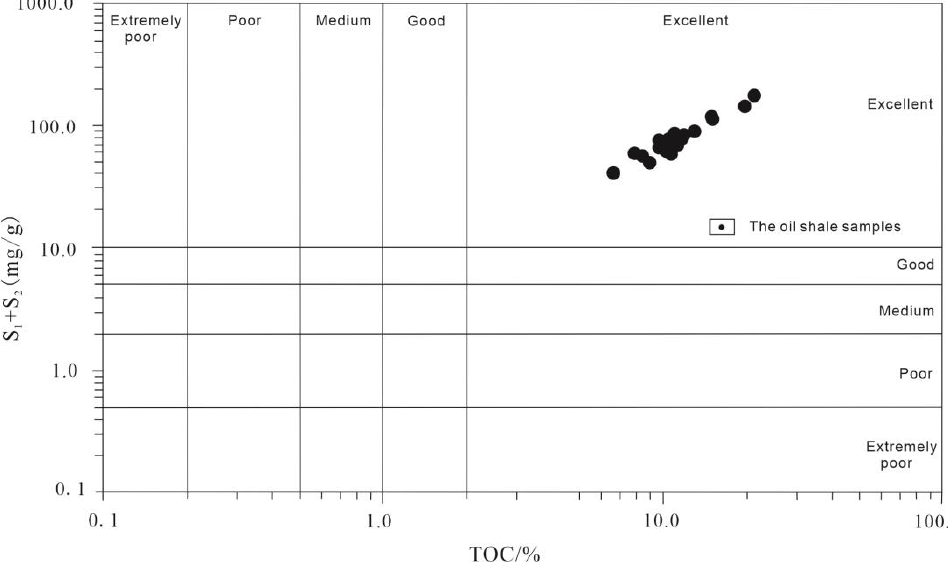
Figure 8. TOC-S 1 + S 2 intersection map of oil shale in Youganwo Formation of Maoming Basin (After Peters and Cassa, 1994).